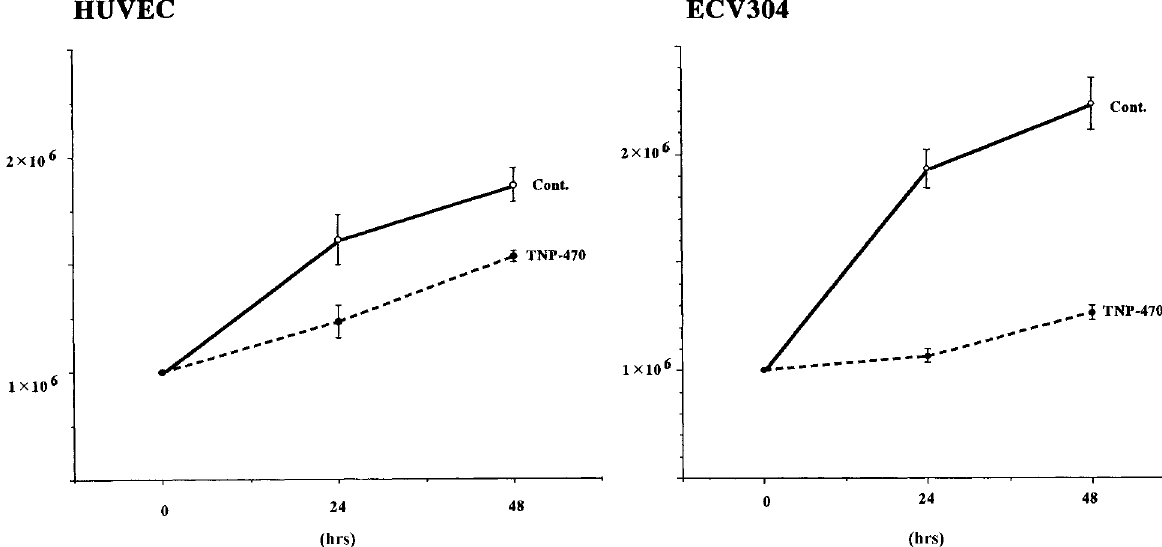
Fig. 3. The effects of conditioned medium from HT1080 treated with TNP-470 on endothelial proliferation. HUVEC and ECV304 were incubated with the conditioned medium from HT1080 treated with or without TNP-470 (10 ng/ml) for 48 hrs. Cells were counted using hemocytometer. Data are means from 3 independent experiments ± SEM.